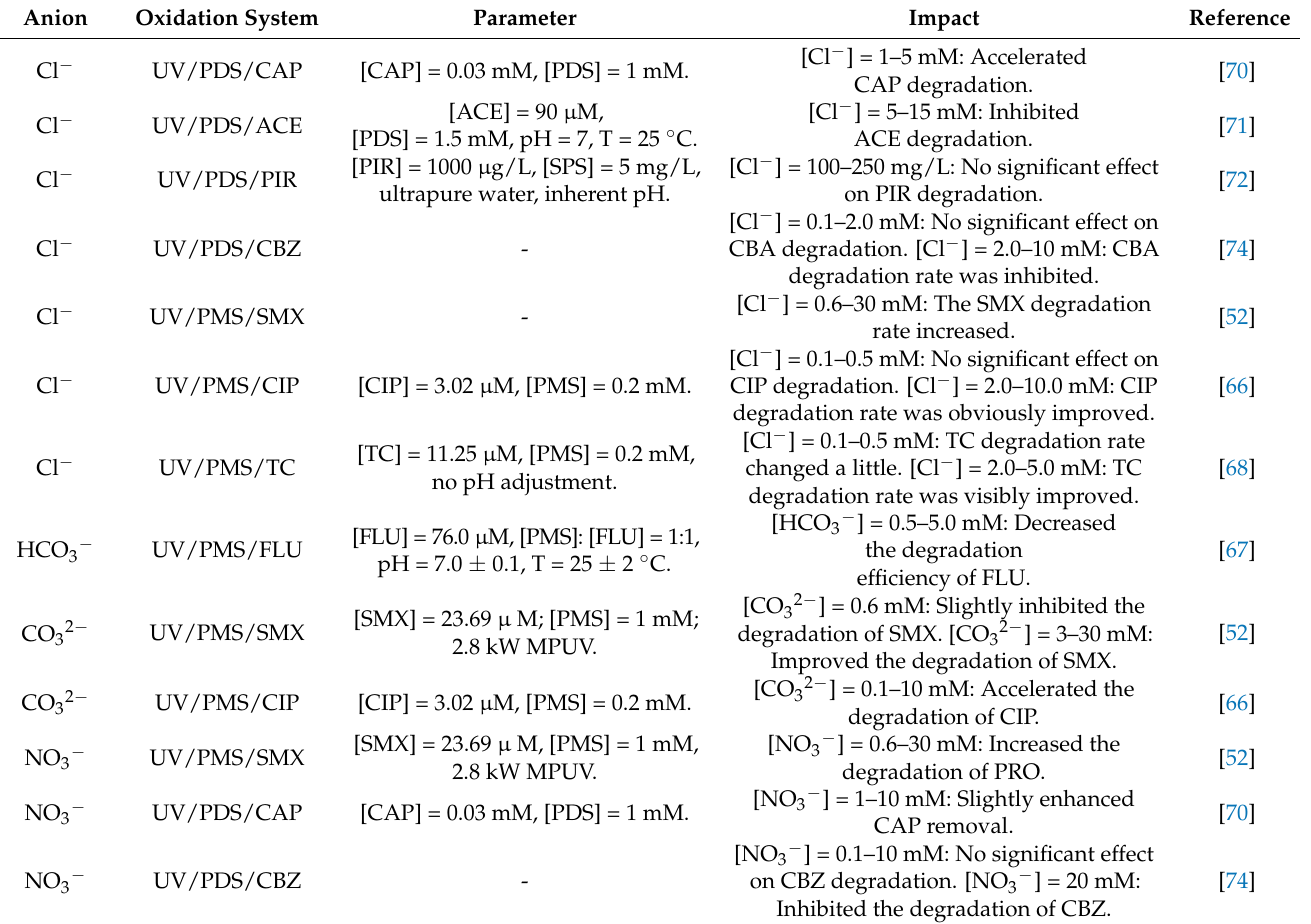
Table 4. Effects of different ions on antibiotics degradation in PDS/PMS